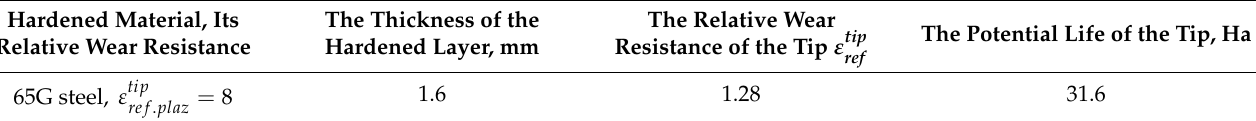
Table 3. The rational thickness of the hardened layer and the potential service life of the ploughshare tip on the example of 65G steel ( ε = 1.28).